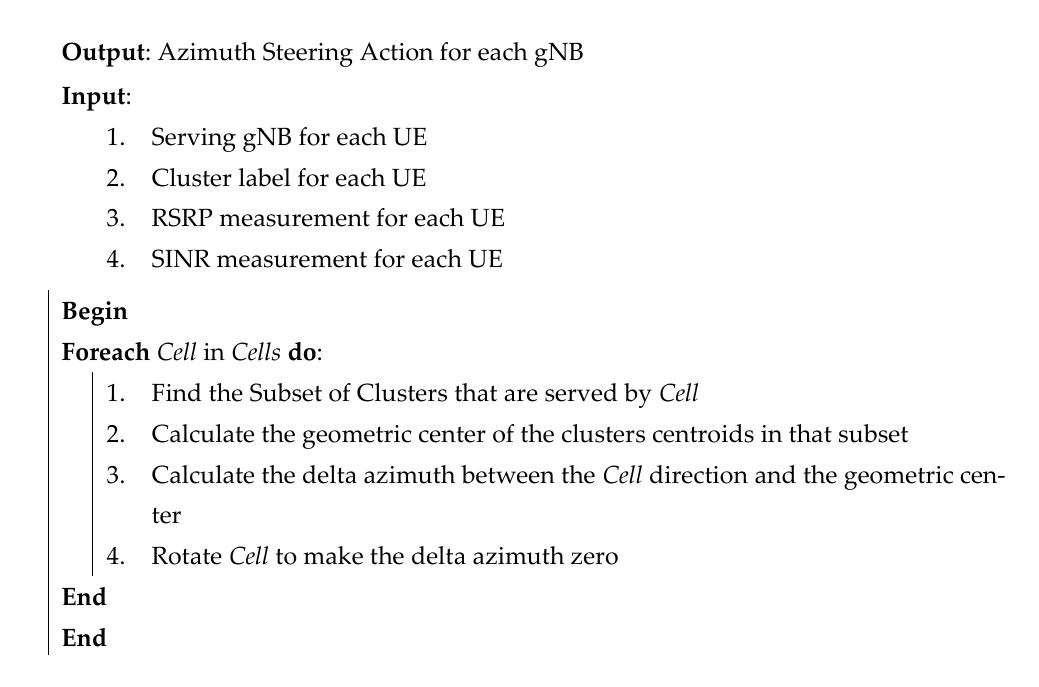
Baseline Algorithm 2: Azimuth Steering based on Spatial Clustering